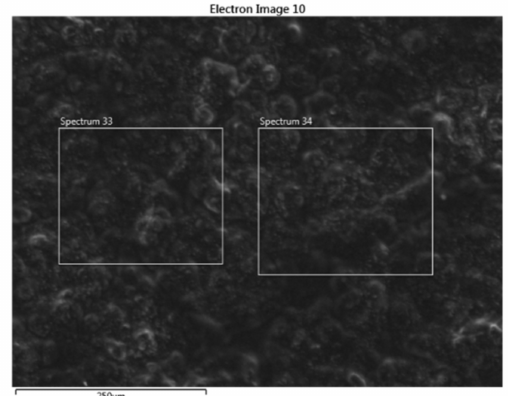
Figure 3. SEM image of Fe-C